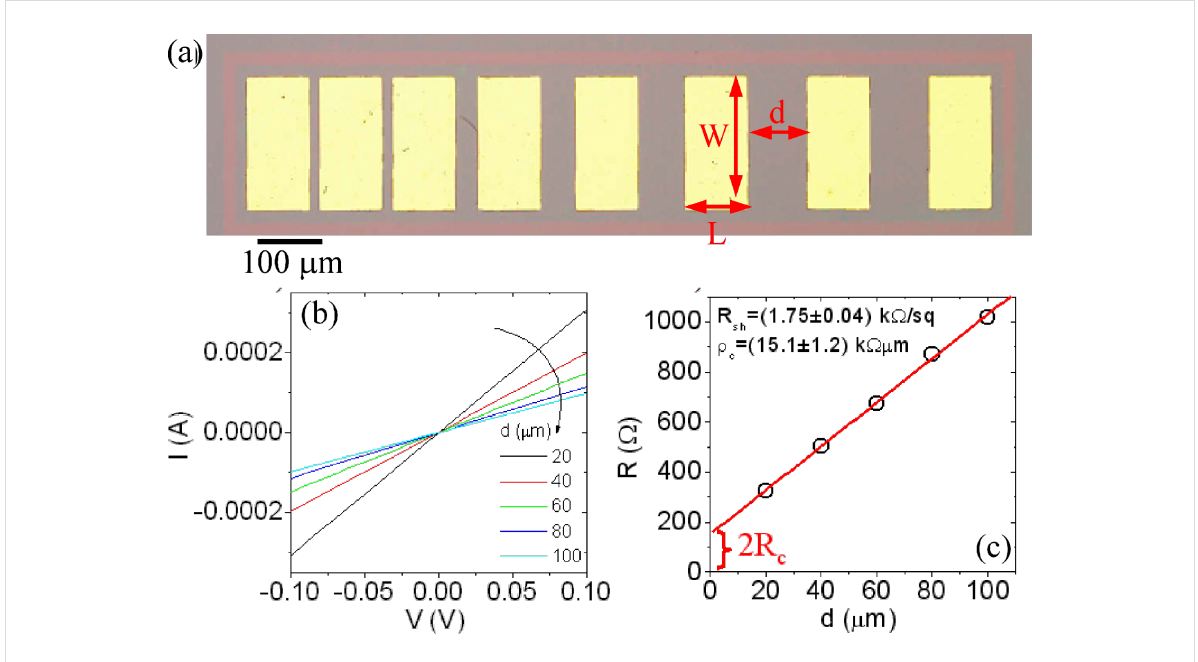
Figure 4: (a) Optical Image of a TLM structure, (b) I – V characteristics measured between pairs of contacts at different distances and (c) extracted resistance plotted versus distance. From the linear fit of R versus d , the sheet resistance and the specific contact resistance were evaluated.